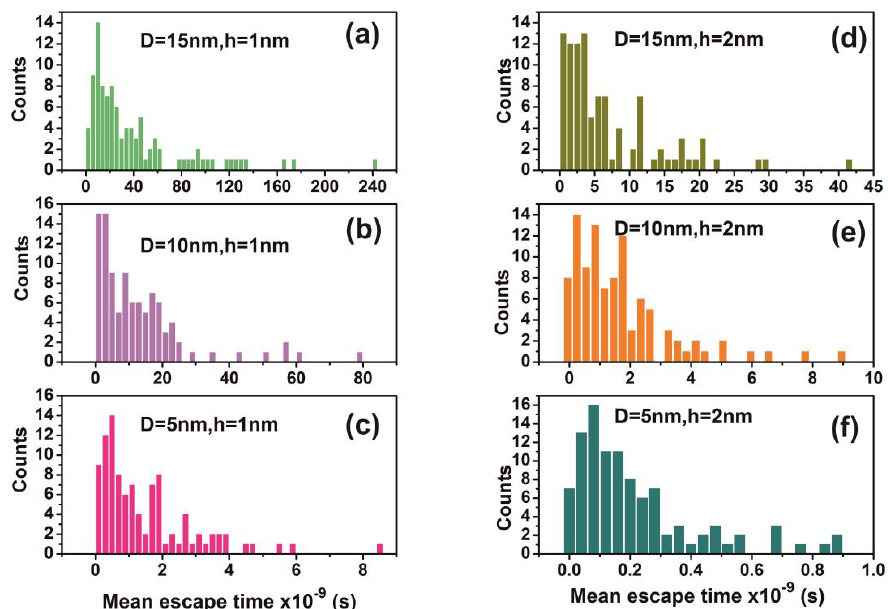
Figure 13. Distribution of mean escape times for 10 2 random walk runs of a water molecule (non-interactive model) for different cavity geometries (cavity size D and entrance-escape hole size h). ( a ) D = 15 nm, h = 1 nm; ( b ) D = 10 nm, h = 1 nm; ( c ) D = 5 nm, h = 1 nm; ( d ) D = 15 nm, h = 2 nm; ( e ) D = 10 nm, h = 2 nm ( f ) D = 5 nm, h = 1 nm. Distributions are non-normal and besides that skewness and long tails indicate non-equilibrium processes inside the cavities.